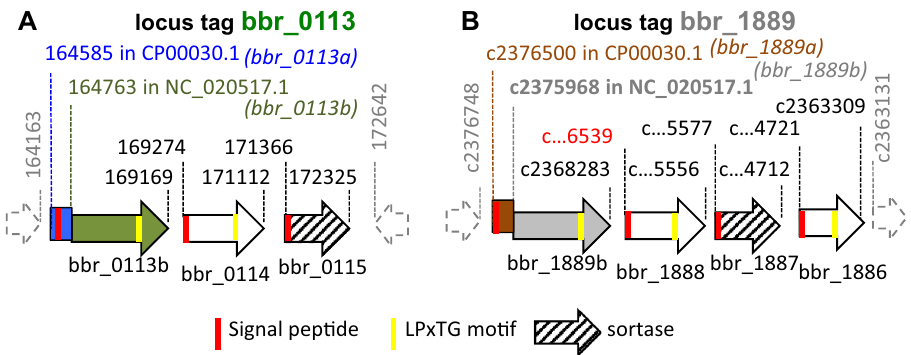
Figure 1. Sortase-dependent pilus gene clusters of UCC2003. Genetic organization of the locus containing bbr_0113 ( A ) and bbr_01889 ( B ). Coding sequences are indicated with an arrow, with the annotated bbr_0113 (green) bbr_1889 ORF (grey) re-named bbr_0113b and bbr_1889b . The corresponding upstream ORF is named bbr_0113a (blue) and bbr_1889 (brown). Other sortase-dependent pilus genes are highlighted in white and the dedicated sortase enzyme by a stripped arrow. Signal peptide and LPTxG motifs are indicated by vertical red and yellow bars respectively. The UCC2003 genomic coordinates of NC_020517.1 are indicated above the